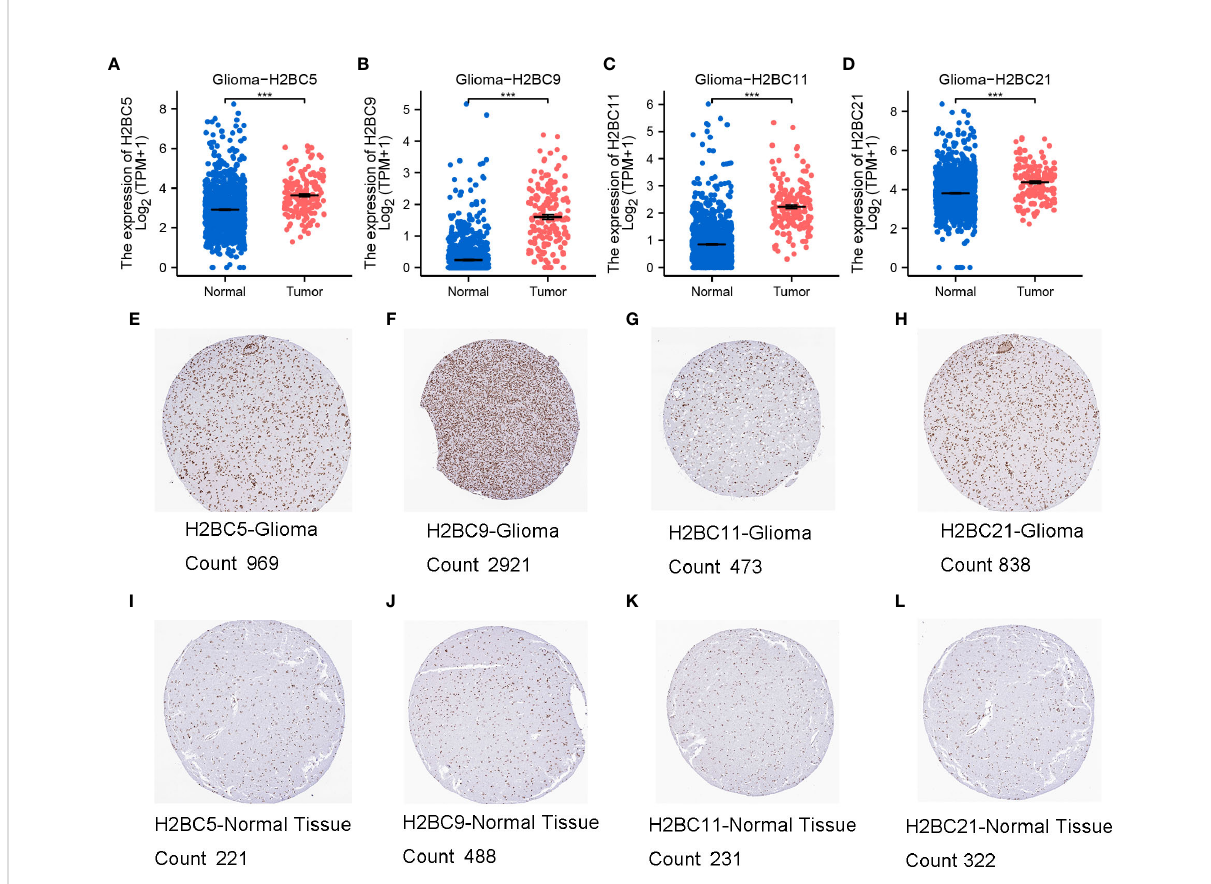
FIGURE 2 Expression of H2BC5, H2BC9, H2BC11, and H2BC21. (A – D) H2BC5, H2BC9, H2BC11, and H2BC21 genes were highly expressed in glioma. H2BC5, H2BC9, H2BC11, and H2BC21 protein expression was higher in (E – H) GBM than in (I – L) normal tissue using the Human Protein Atlas database (immunohistochemistry) The brown part represents positive cells. “ Count ” stands for positive cell count. ***P <